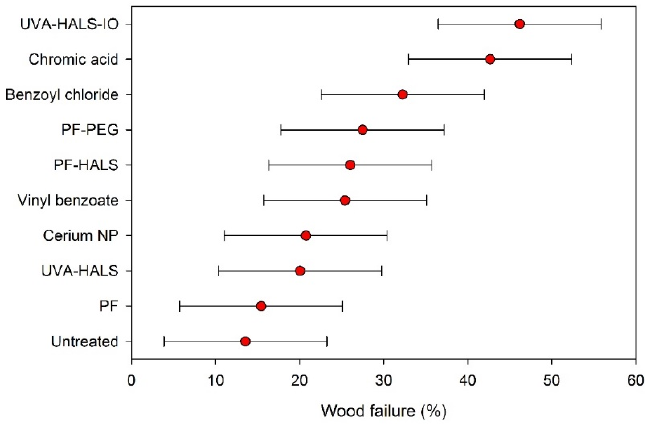
Figure 3. Effect of treatments on wood failure during measurement of the adhesion of coatings to treated yellow cedar test substrates. Results averaged across acrylic and alkyd coatings.